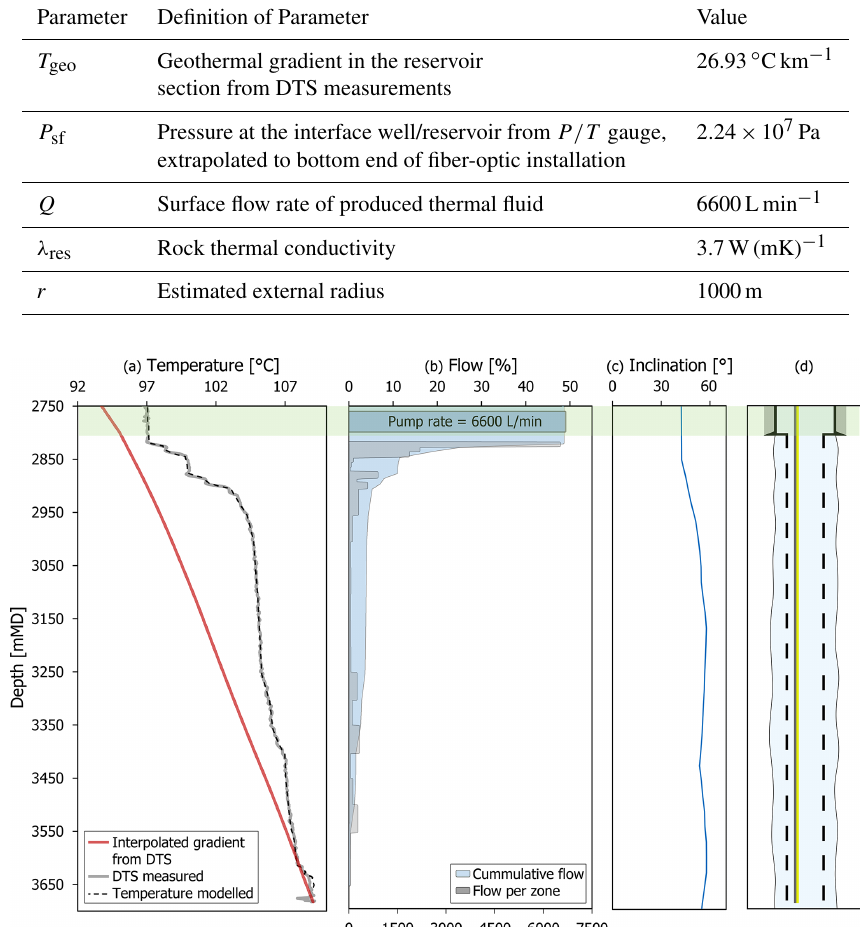
Table 1. Input parameter for the inverse DTS profiling with KAPPA Emeraude.